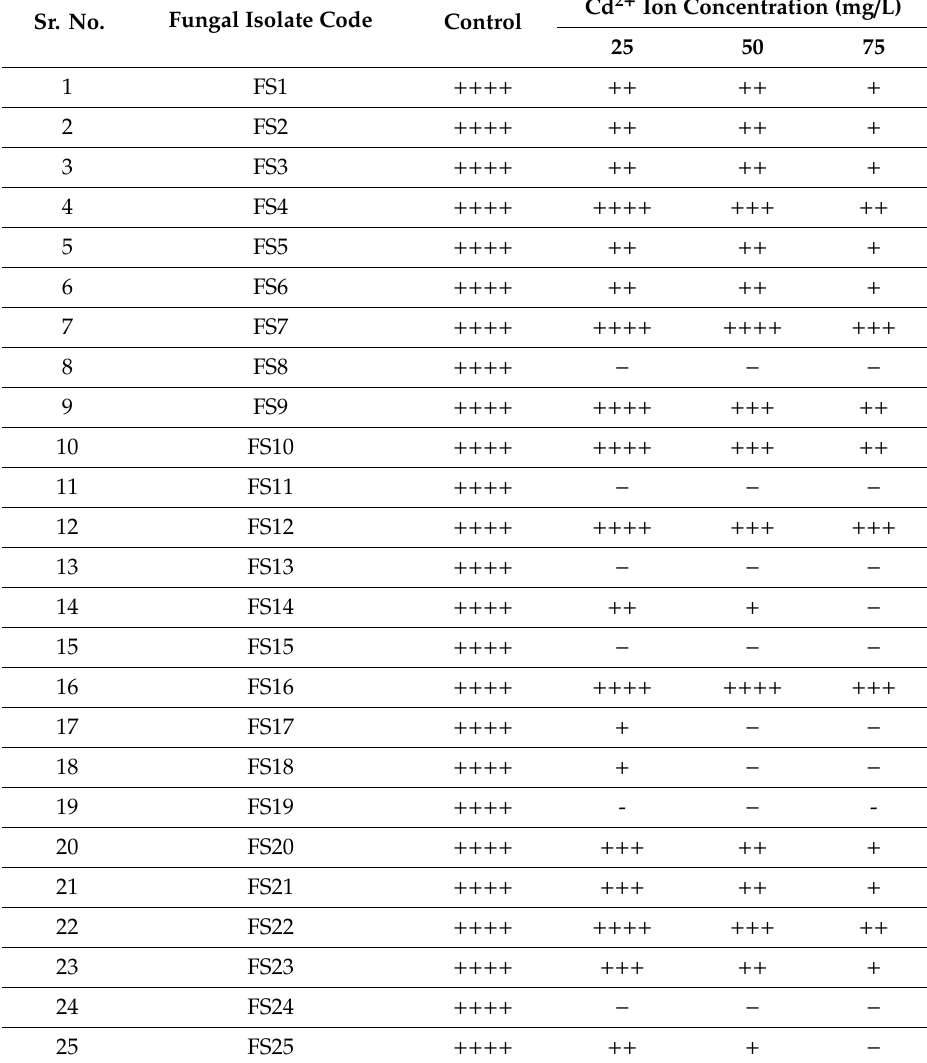
Table 1. Growth profile of all the fungal isolates on potato dextrose agar (PDA) (pH 5.0, temperature 30 ◦ C) containing 25, 50, and 75 mg / L of Cd 2 + after five days. Sr.